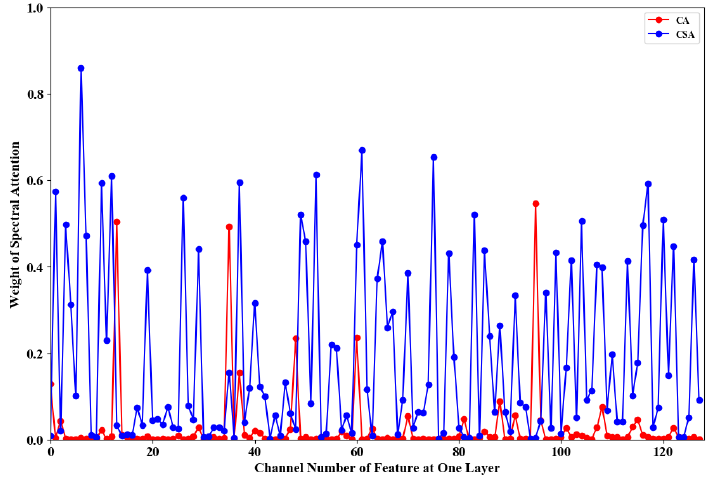
Figure 7. The line chart of kernel weight distribution of CA and CSA. The horizontal axis “Channel Number of Feature at One Layer” is also equal to the number of feature kernels, and the vertical axis “Weight of Spectral Attention” indicates the weight learned from spectral attention. In addition, the five highest in the CA red line are considered to be the five most important feature kernels. And the weight of CSA blue line is calculated by the mean of each band. From the outcome of CSA, it is clear that its high weights distribute everywhere, which is viewed as being not good for attention.